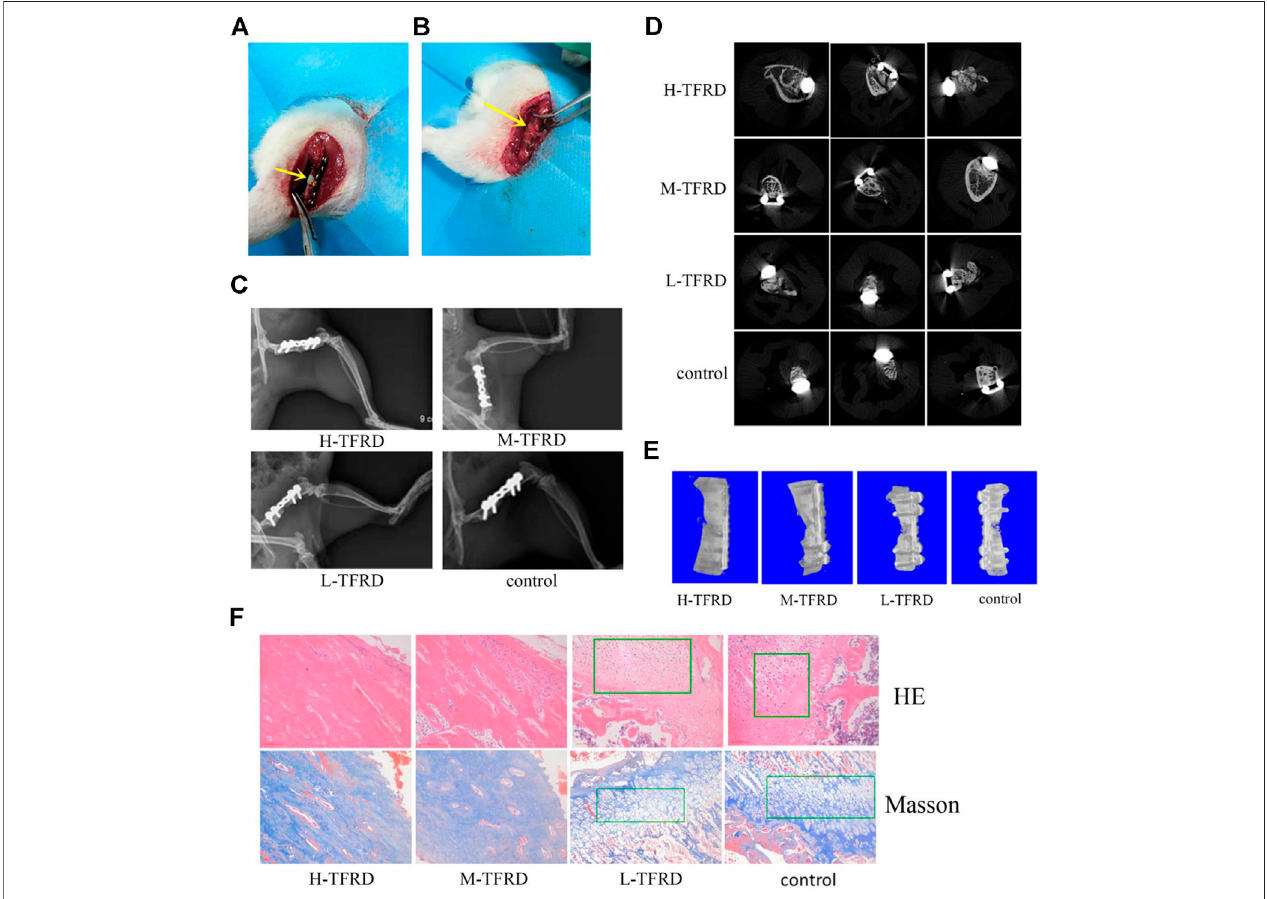
FIGURE 1 | TFRD accelerates the growth and mineralization of bone graft. (A) The yellow arrow in the picture refers to the 6 mm bone defect constructed in the right femur ofratsduringthe fi rststage operation. PMMA spacerwasimplanted in thisareatoinduce formationofbio fi lm. (B) Theyellow arrow refers totheareaofbone graft in the right femur of rats at the second stage operation. (C) X-ray was performed on the right femur of rats. Among them, the amount of callus and cortical bone shaping in the H-TFRD and M-TFRD groups were more obvious than those in the L-TFRD and control groups. (D) was the result of Micro-CT cross-sectional scanning of the bone graft in the right femur of rats. (E) was the results of three-dimensional reconstruction of the right femur of rats. (F) shows the histological and structural characteristics of bone graft in the right femur of rats (magni fi cation, × 200). The green boxes show the cartilage area, and other parts in pictueres show the osteogenic